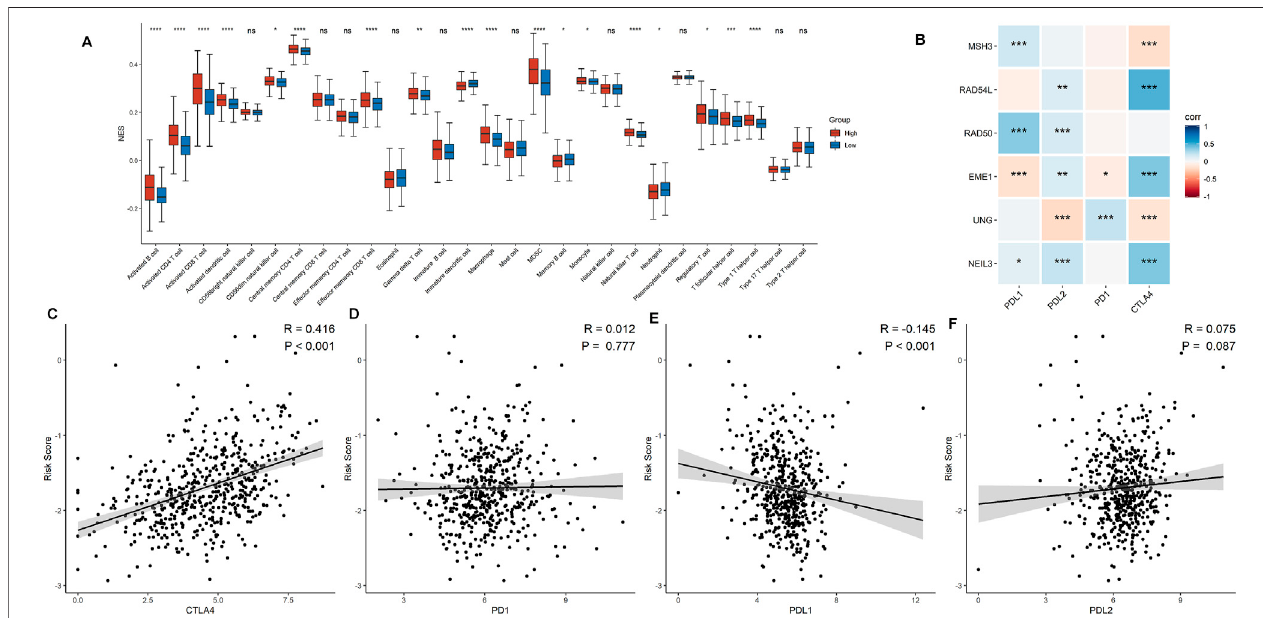
FIGURE6| Associationbetweentherisksignatureandimmune-relatedcharacteristic. (A) Thedistributionoftheimmunecellin fi ltrationlevelsbetweenthelow-and high-riskgroups. (B) Correlation analysisforthesixsignatureDDRGswiththedifferentimmunecheckpointmarkers. (C − F) Correlationanalysisfortheriskscoreandthe immune checkpoint makers including CTLA4 (C) , PD-1 (D) , PD-L1 (E) , and PD-L2 (F)